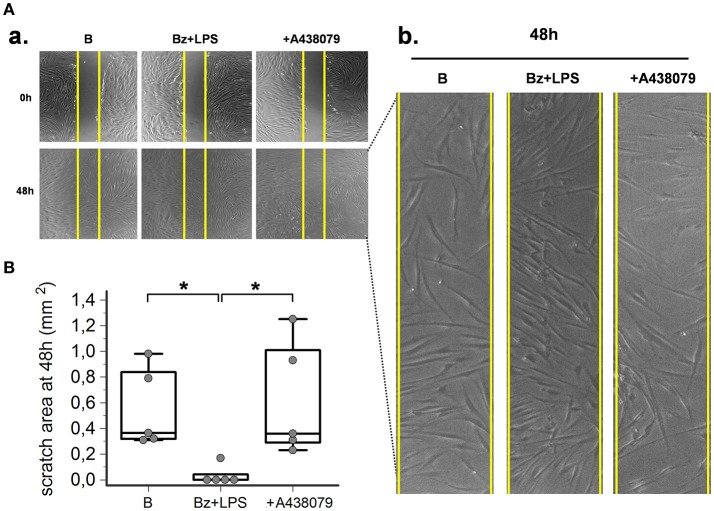
P2X7R stimulation increases SSc fibroblasts migration. P2X7R-dependent migration of SSc dermal fibroblasts, as determined by in vitro scratch-wound healing assays. (A) (a) Representative figure of an experiment. Cells are stimulated with Bz+LPS alone or in association with the P2X7R antagonist A438079 (50 μM). Photos were taken immediately after wounding (0 h) and 48 h later. Yellow vertical lines show the scratch area, as initially measured at 0 h. (b) Magnification of the scratch area at 48 h. (B) Effect of Bz+LPS and Bz+LPS+AR438079 on SSc dermal fibroblast migration, as determined by the scratch area at 48 h. Plots represent 5 different experiments performed by using fibroblasts from 3 different SSc patients. Kruskal–Wallis test (non-parametric ANOVA), p = 0.0083; post-hoc two-tailed Dunn multiple comparison test, *p < 0.05. SSc, Systemic sclerosis; P2X7R, P2X7 receptor; B, baseline; Bz, 2′-3′-O-(4-benzoylbenzoyl)ATP; LPS, lipopolysaccharide; ANOVA, analysis of variance.